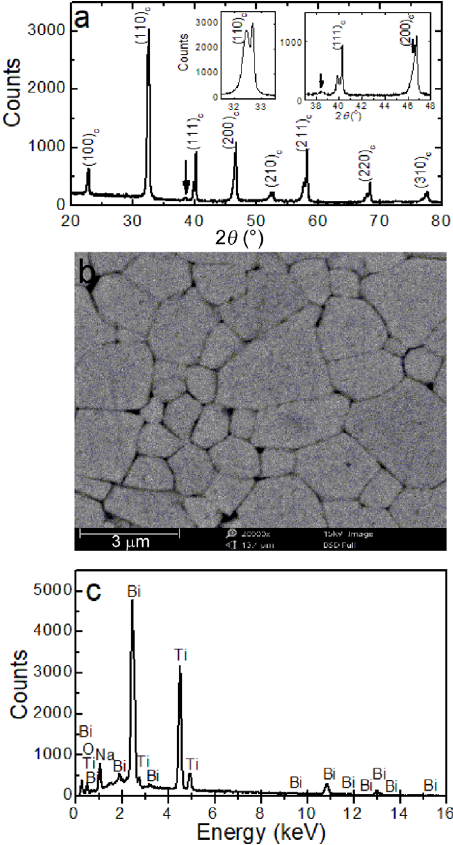
surface, and (c) EDS analysis of the NBT ceramics.